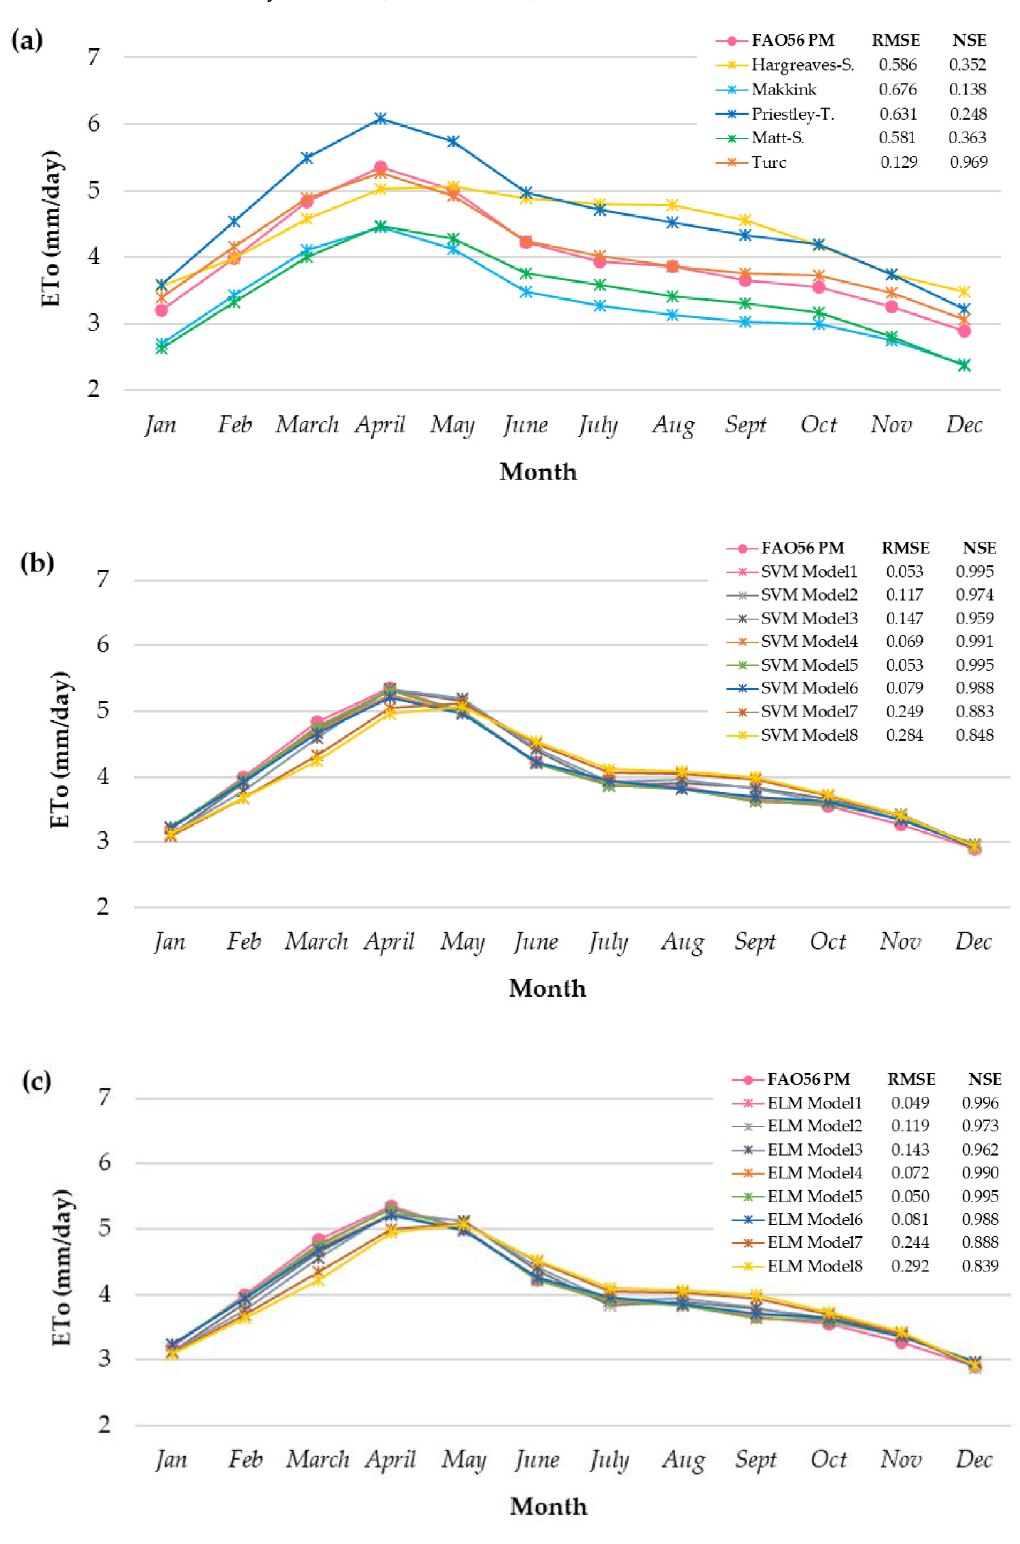
Figure 3. Plots of monthly average daily ETo at the UPLB station estimated from ( a ) empirical equations, and calibrated machine learning models of ( b ) Support Vector Machine and ( c ) Extreme Learning